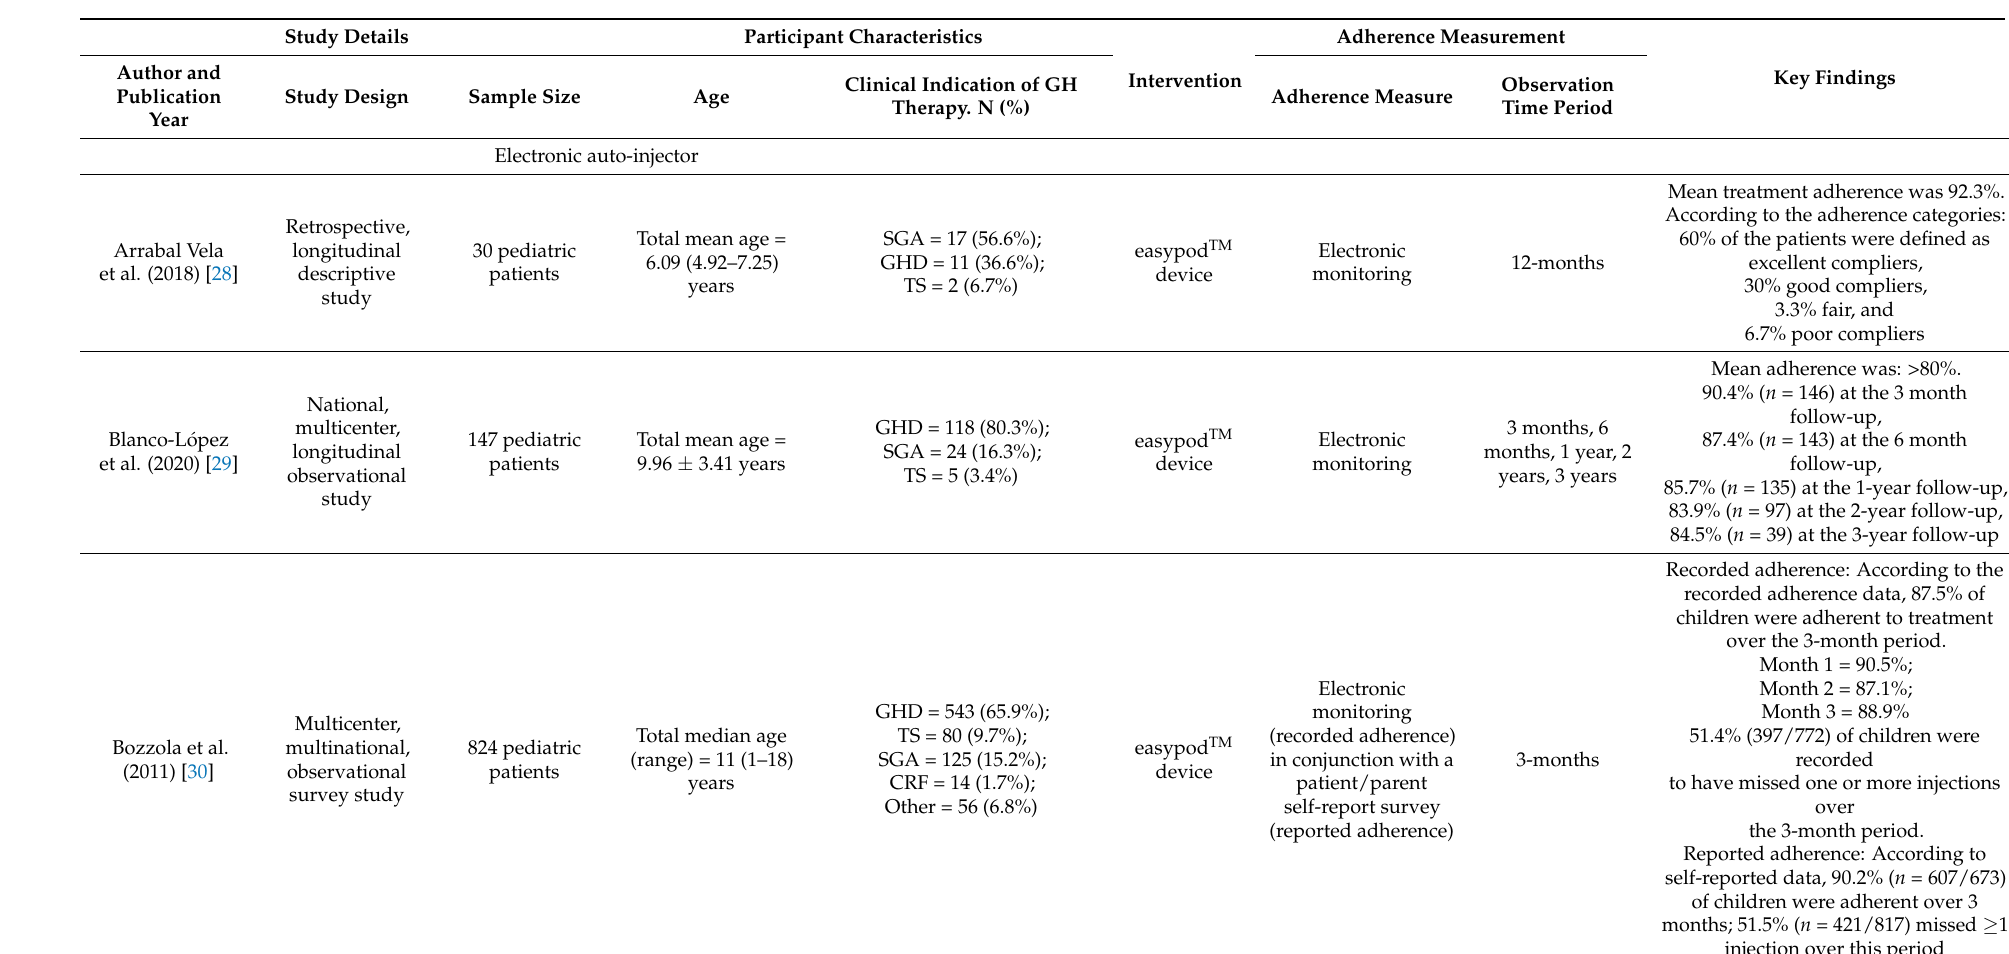
Table 1. Summary Data Extraction